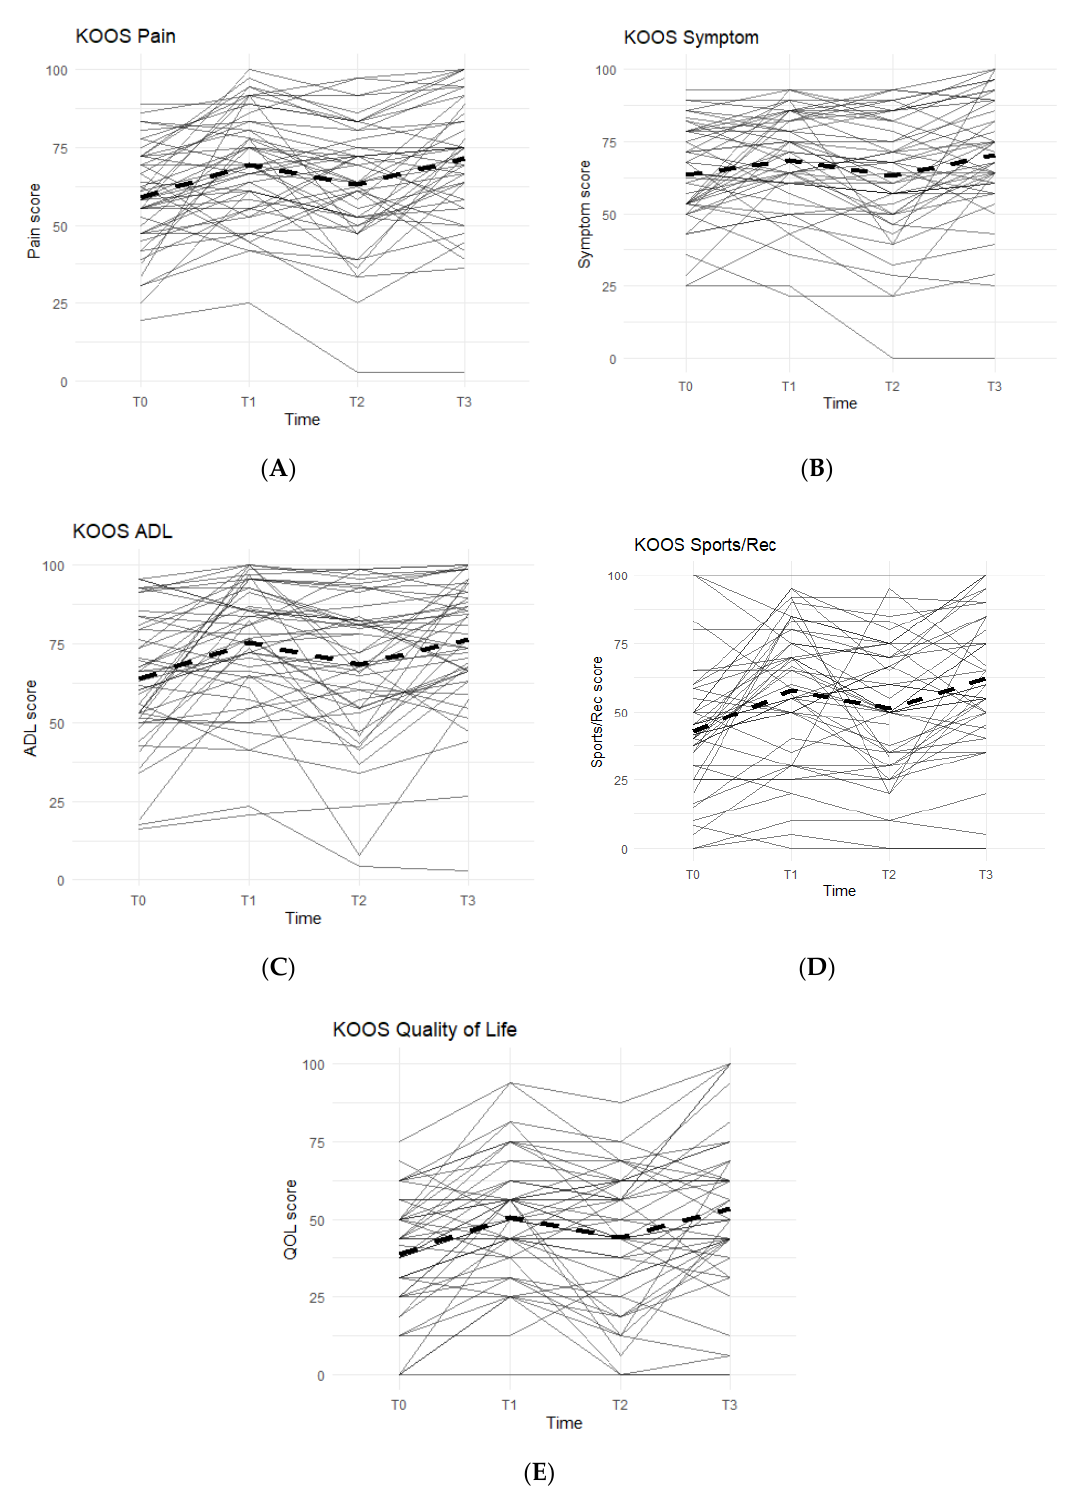
Figure 1. KOOS Scores of the Entire Study Cohort ( n = 51). Score averages were graphed for the entire cohort throughout each phase. Solid lines represent individual participant scores. Thick dashed lines represent group averages. ( A ) shows the KOOS Pain scores from T0–T3. ( B ) shows the KOOS Symptom scores from T0–T3. ( C ) shows the KOOS ADL scores from T0–T3. ( D ) shows the KOOS Sports/Rec scores from T0–T3. ( E ) shows the KOOS Quality of Life scores from T0–T3.